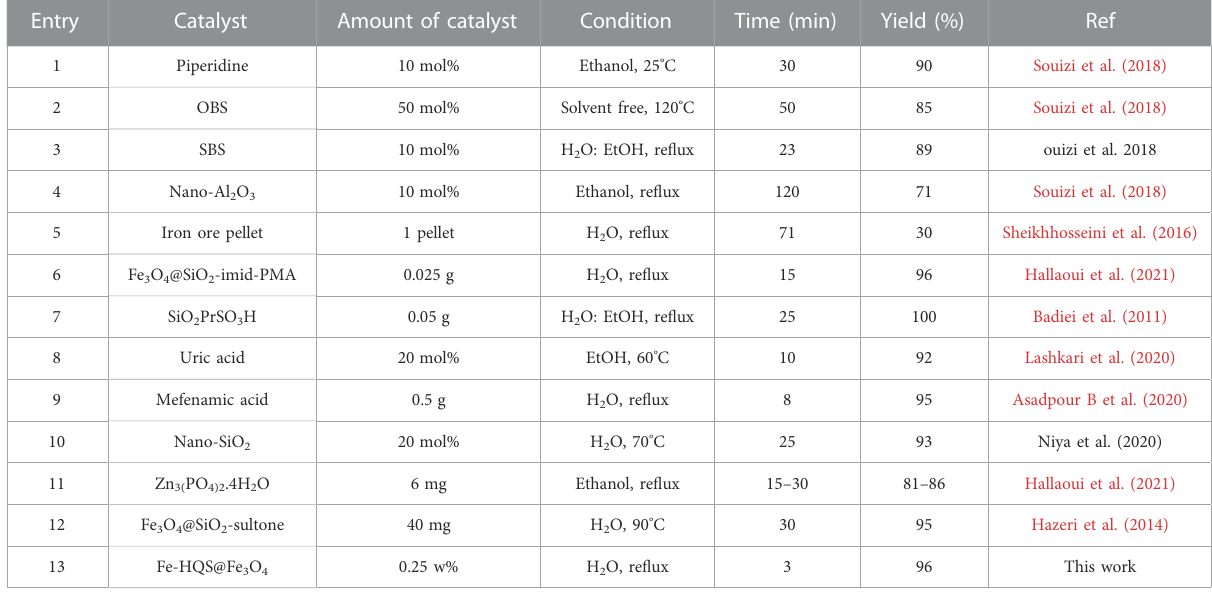
TABLE3Comparison ofresults obtainedinthepresenceofCBFe-hydroxyquinoline@Fe 3 O 4 NFCwithothercatalystsreported intheliterature inthesynthesis of